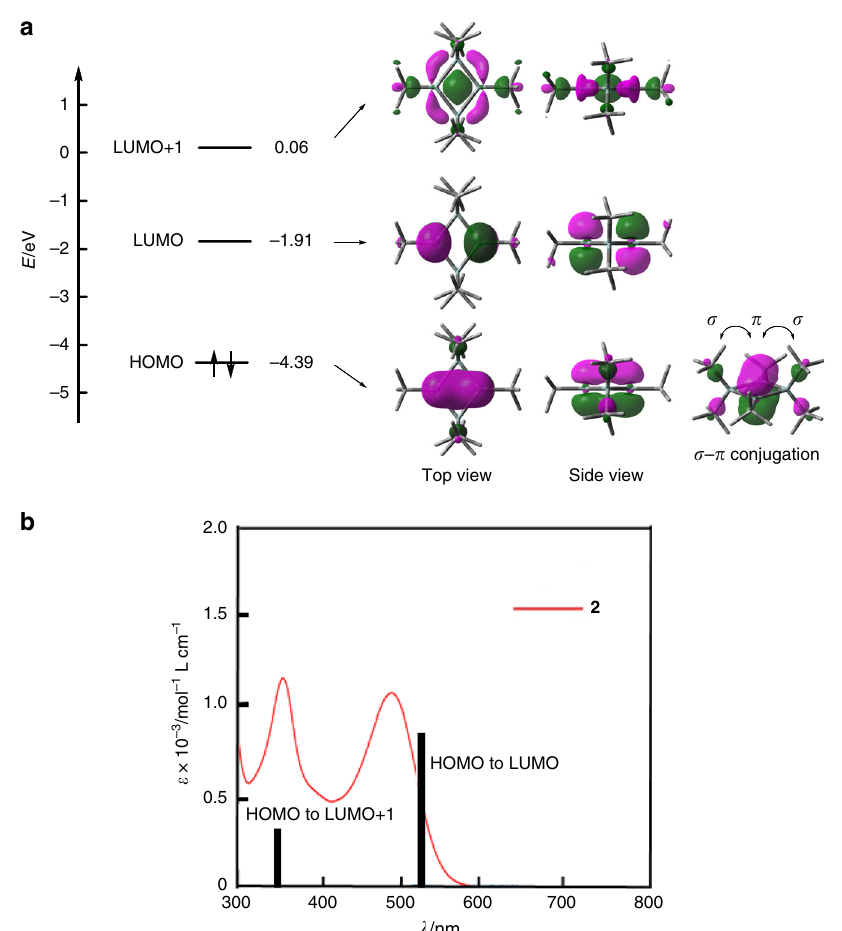
Fig. 2 Electronic properties of 2. a Frontier orbitals and their energy levels of 2 calculated at the B3LYP/6-31G(d) level. b UV/Vis spectrum of 2 in benzene at room temperature with transitions calculated at the TD-DFT B3LYP/6-31G(d)